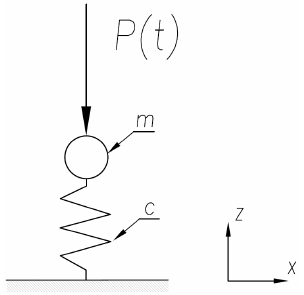
Figure 2. Mass resting on a spring with exciting force P(t) .